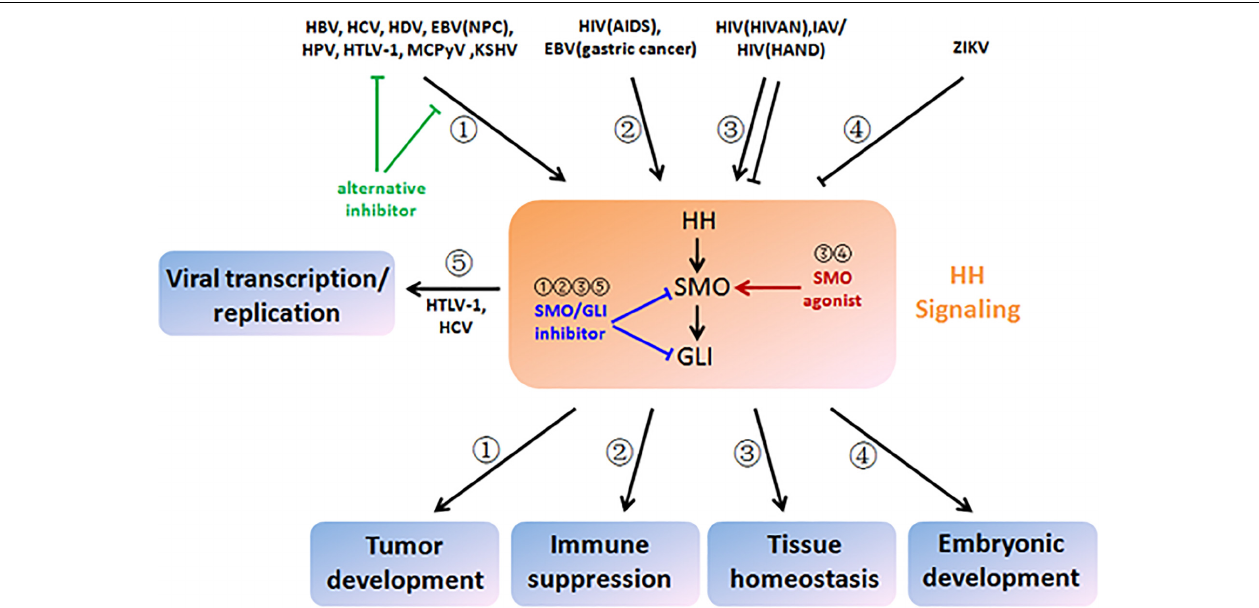
FIGURE 3 | Therapeutic strategies based on viral modulation and pathological outcome of HH signaling. HBV, HCV, HDV, EBV (nasopharyngeal carcinoma), HPV, HTLV-1, MCPyV, and KSHV aberrantly activate HH signaling and drive multistep tumor development (pathway (cid:192) ). HIV (acquired immune deficiency syndrome) and EBV (gastric cancer) also activate HH signaling, which contributes to immune suppression (pathway (cid:193) ). HIV (HIV-associated nephropathy), IAV, and HIV (HIV-associated neurocognitive disorder) disturb tissue homeostasis by induction of either increased or decreased HH signaling (pathway (cid:194) ). ZIKA infection results in disruption of embryonic development by inactivation of HH signaling (pathway (cid:195) ). HTLV-1 and HCV hijack HH signaling and facilitate viral transcription and replication (pathway (cid:196) ). To reverse viral modulation and restore to the normal activity of HH signaling, SMO/GLI inhibitors could be applied to the scenarios of (cid:192) , (cid:193) , (cid:194) , and (cid:196) (blunt arrows in blue), while SMO agonists could be applied to the scenarios of (cid:194) and (cid:194) (sharp arrows in red). Alternatively, chemical inhibitors could also target viral proteins that crosstalk with HH signaling or their interactions for blockage (blunt arrows in